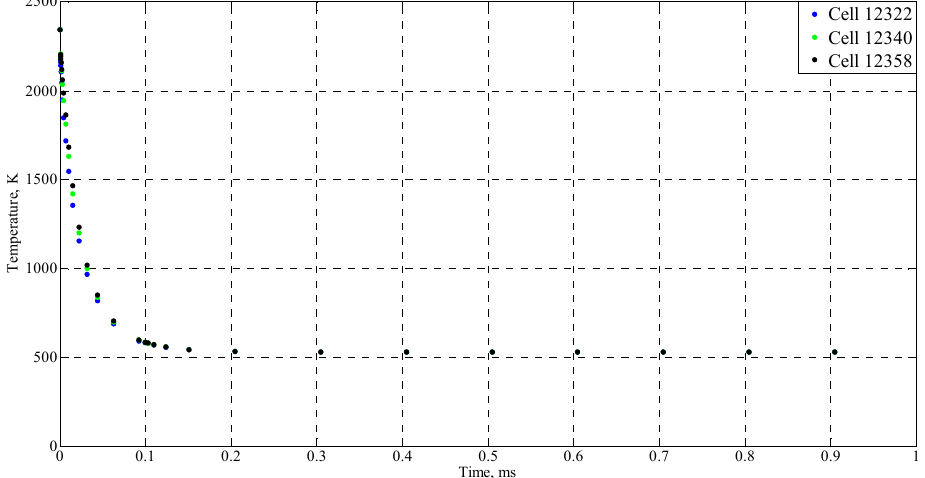
Figure 16. Temperature evolution in the splat cells 12322, 12340 and 12358 with preheating substrate.